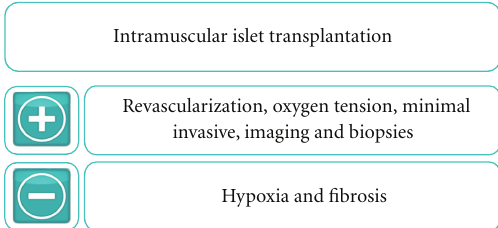
Figure 1: Summary of beneficial aspects and known obstacles for intramuscular islet